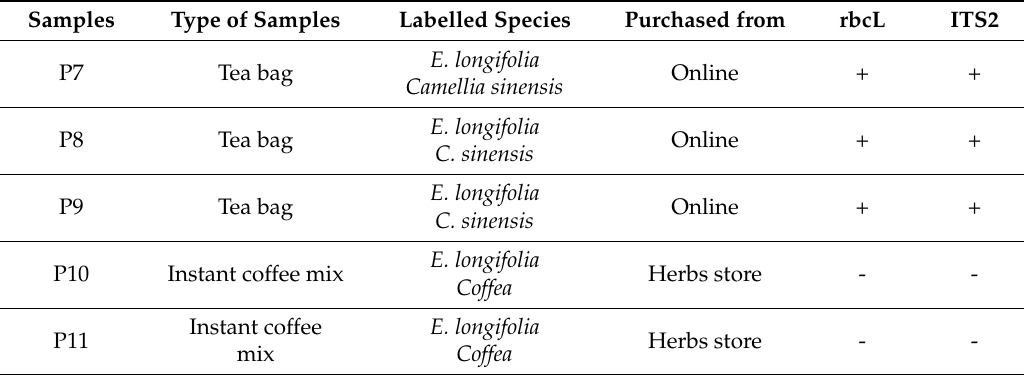
Table 2. Tested commercial tea bags and coffee instant drink powder containing traces of E. longiolia as herbal additives abbreviated as P7–P11 for the High Resolution Melting (HRM) sensitivity assessment (Section